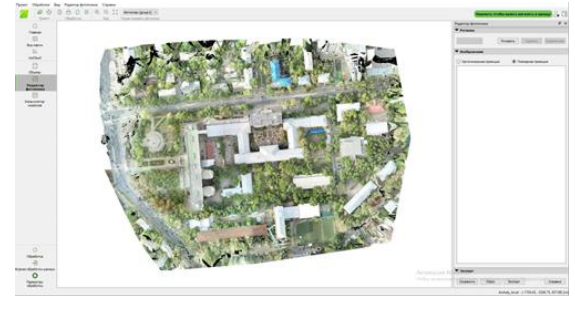
Figure 4. Orthophoto map.